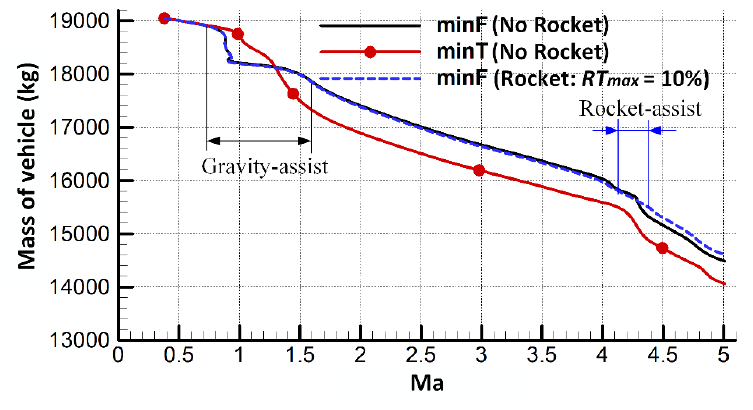
Figure 6. Vehicle mass profiles.